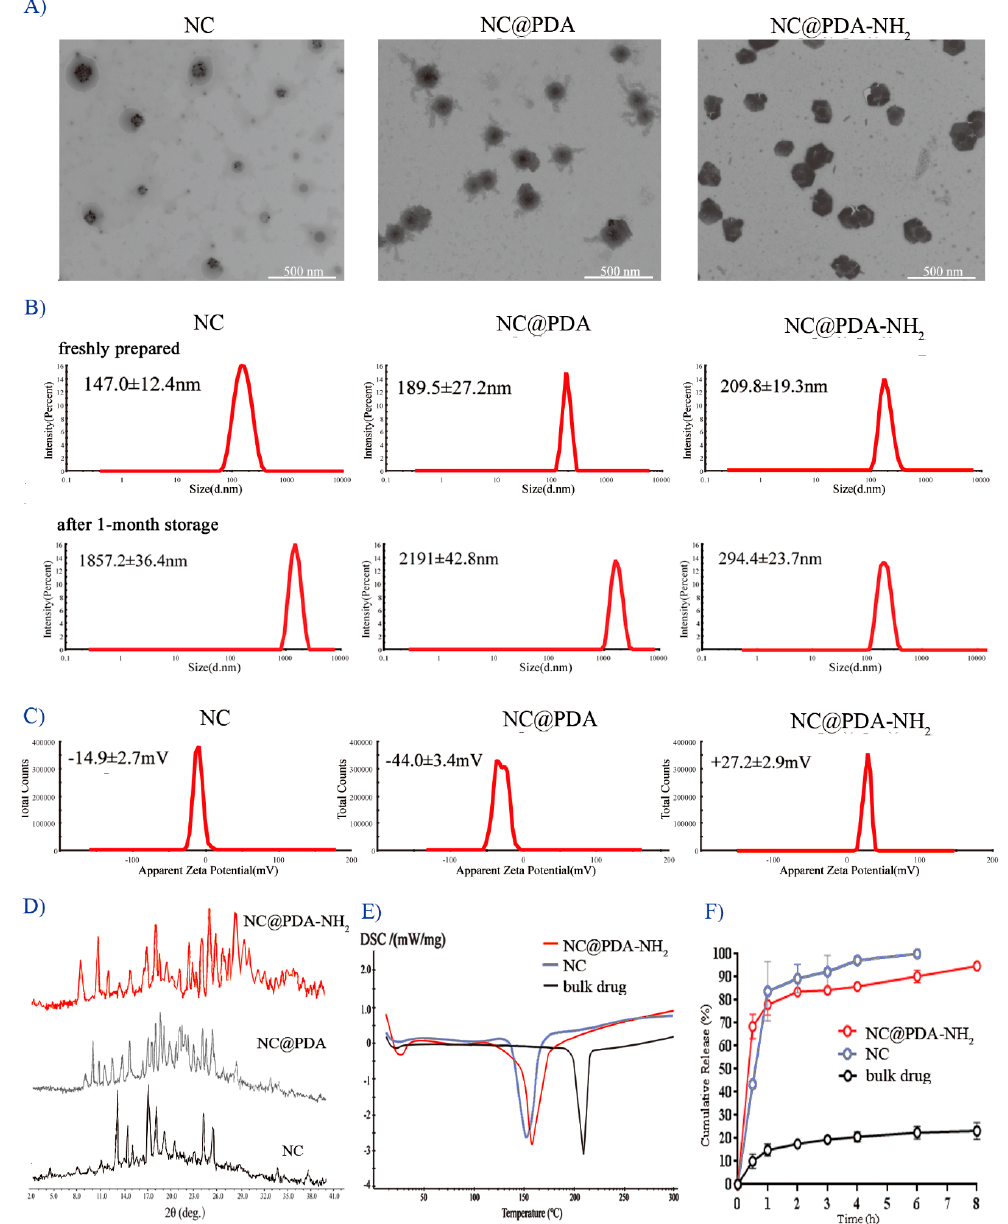
Figure 1. Characterization of NC, NC@PDA, and NC@PDA ‐ NH 2 . ( A ) TEM images. ( B ) size distribution measured by dynamic light scattering (DLS). Upper panels: freshly prepared; lower panels: after one month of storage. ( C ) Zeta ‐ potential measured by DLS. ( D ) X ‐ ray diffraction (XRD) patterns. ( E ) Differential scanning calorimetry (DSC) curves. ( F ) In vitro release profiles in vaginal fluid simulant (VFS) ( n = 3, mean ±